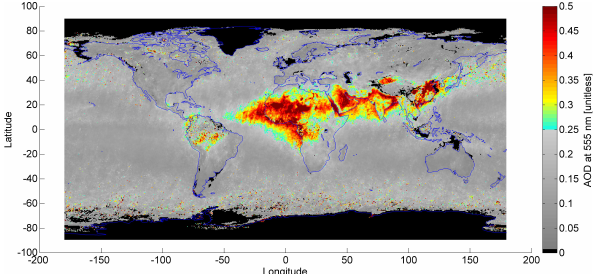
Fig. 13. The global annual mean AOD at 555 nm from the MISR AOD product for the year 2010. Color coding set to highlight re- gions where the annual mean exceeds 0.25; full range of data not